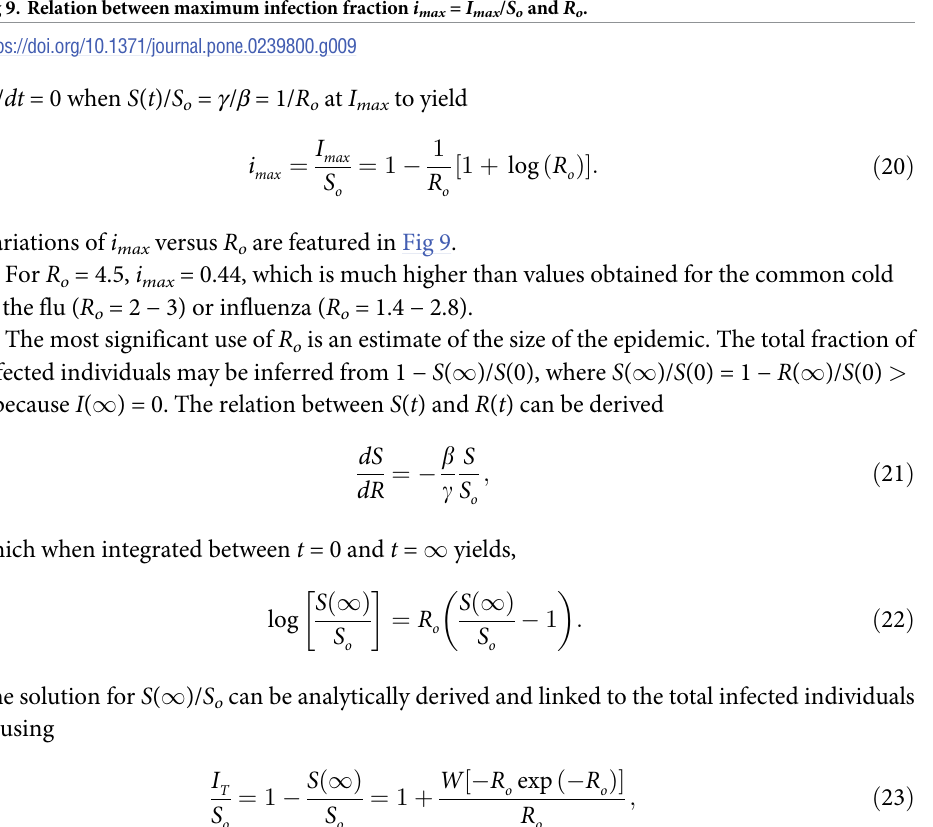
Fig 9. Relation between maximum infection fraction i